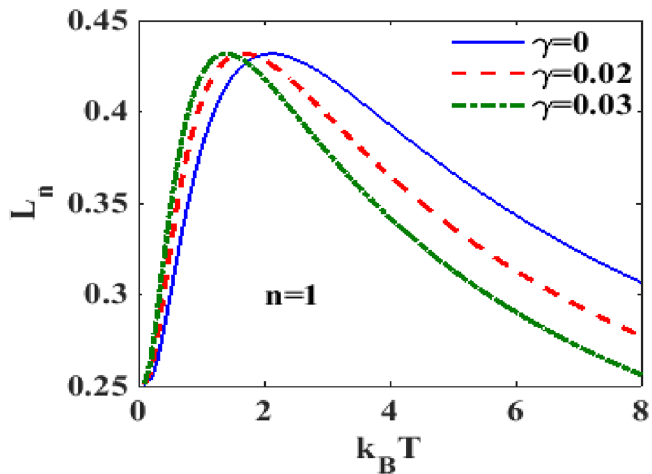
Figure 5. L n versus k B T for different γ at (cid:31) = 0.6 .